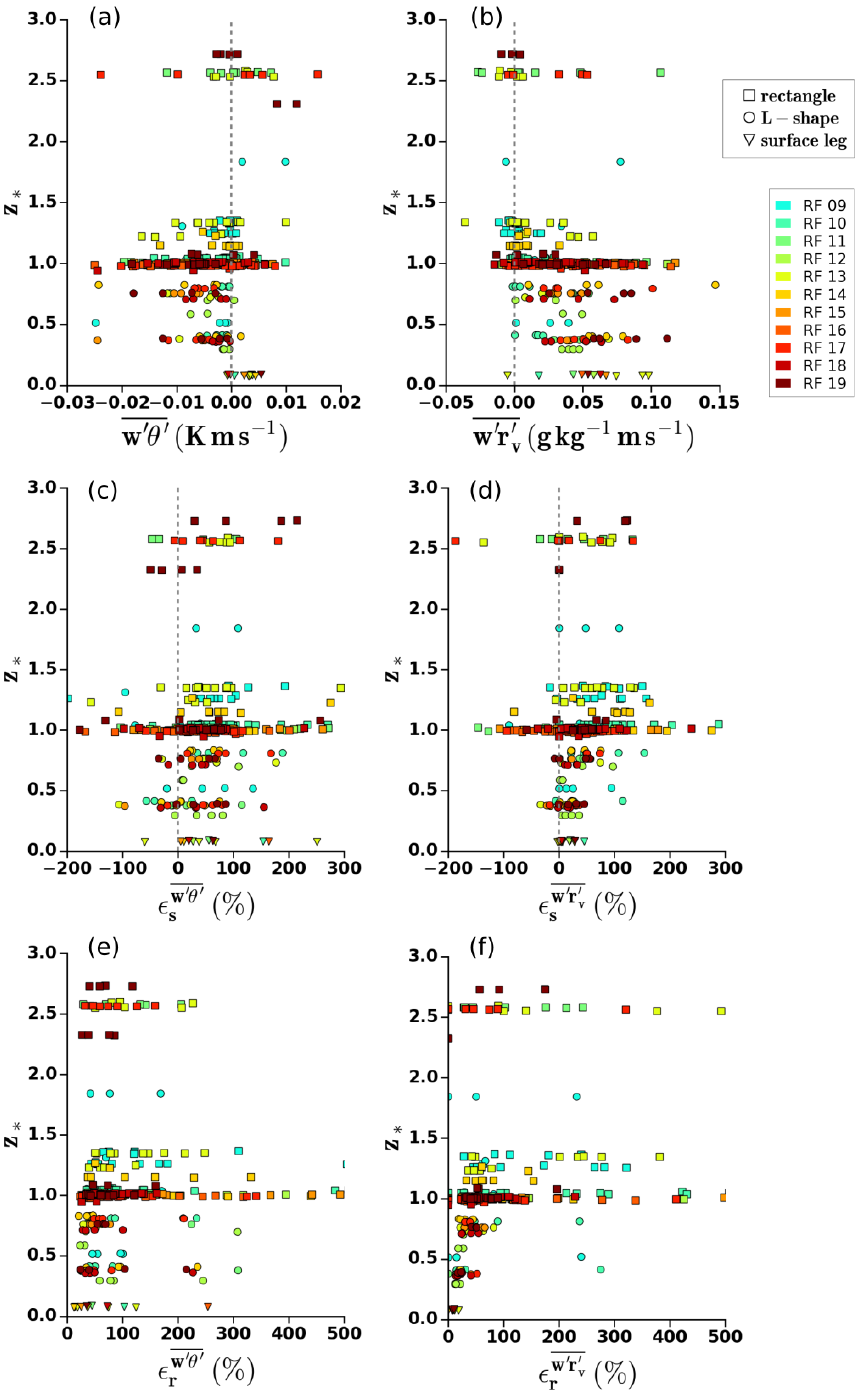
Figure 16. Normalized vertical profiles of (a) the heat flux, (b) the moisture flux, systematic error (c) for the heat flux, systematic error (d) for the moisture flux, random error (e) for the heat flux and random error (f) for the moisture flux. Flight numbers are indicated in the top right box. The normalized altitude z ∗ is defined by z/ LCL with LCL, the lifting condensation level.